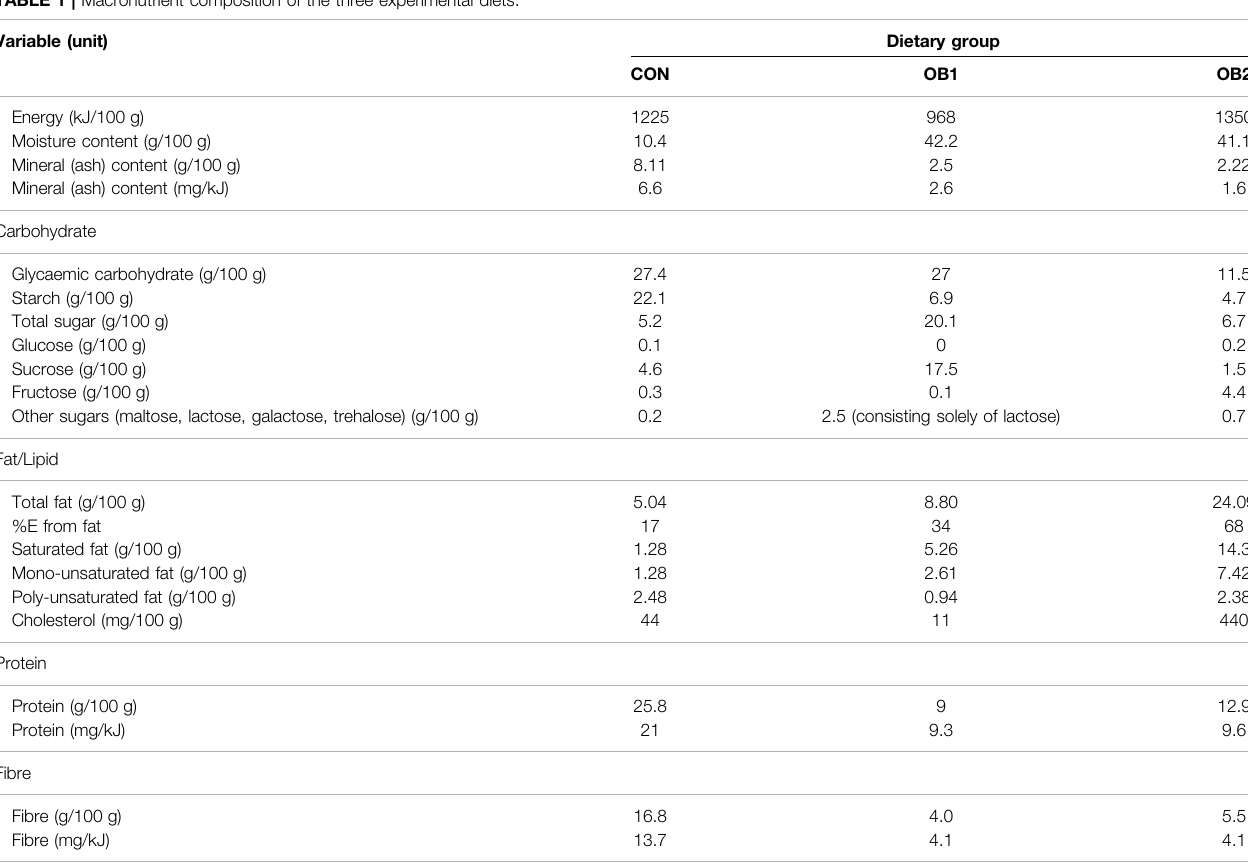
TABLE 1 | Macronutrient composition of the three experimental diets. Variable (unit) Dietary